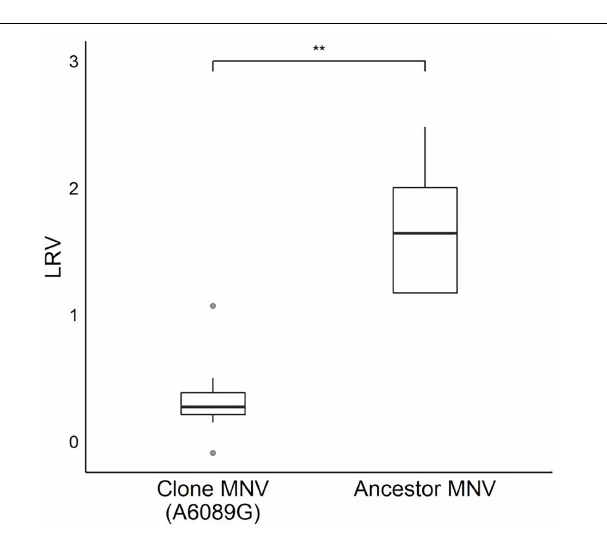
FIGURE 6 | Log reduction values (LRVs) of infectious particles produced using a plasmid-based reverse genetics system [clone MNV (A6089G)] and the laboratory strain used as the founder in the serial passages with lime treatment (ancestor MNV). Asterisks indicate a statistically difference between the two viruses ( p < 0.01 by Mann–Whitney U